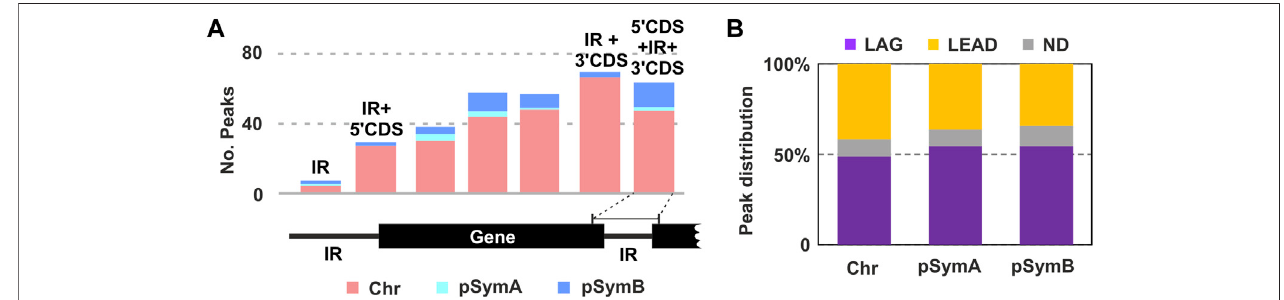
FIGURE4| ResultoftheRmInt1 ChIP-Seqanalysis. (A) Genomic localizationoftheidenti fi edRmInt1 bindingsites. Barplotshowingthenumber ofpeaks foundin either the coding sequence of a gene (CDS) or the intergenic regions (IR). Counts are itemized by replicon: pink corresponds to binding sites identi fi ed in the chromosome; sky blue corresponds to the pSymA megaplasmid; and, the darker blue corresponds to the pSymB chromid. IR + 3 ′ CDS is not included in the 5 ′ CDS+IR+3 ′ CDS. (B) TheproportionsofenrichedDNAsequenceslocalizingatthetemplateforthelagging(LAG,purple)andleading(LEAD,yellow)strandsatthe replication fork are shown as a percentage in a stacked bar graph. Data are presented by replicon. ND, non-determined (gray).